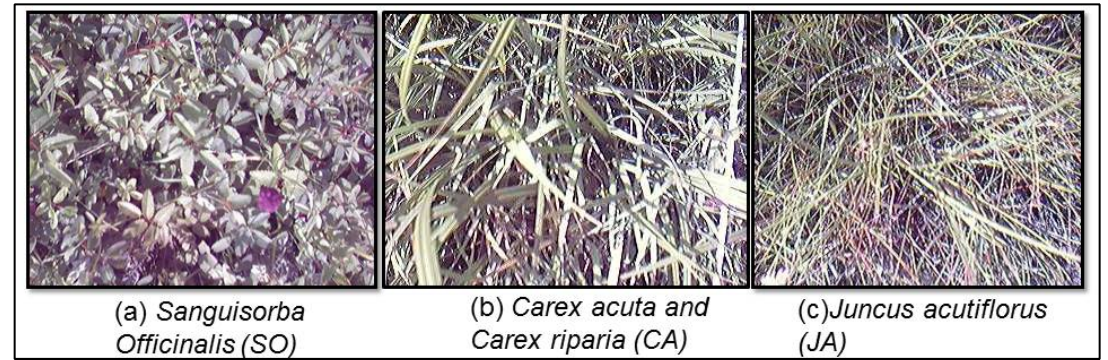
Figure 2. Digital photographs showing top of canopy (1 m height above ground) for ( a ) Sanguisorba officinalis ( SO ); ( b ) Carex acuta and Carex riparia ( CA ) and ( c ) Juncus acutiflorus ( JA ). Photographs taken on 12 and 13 June 2014.